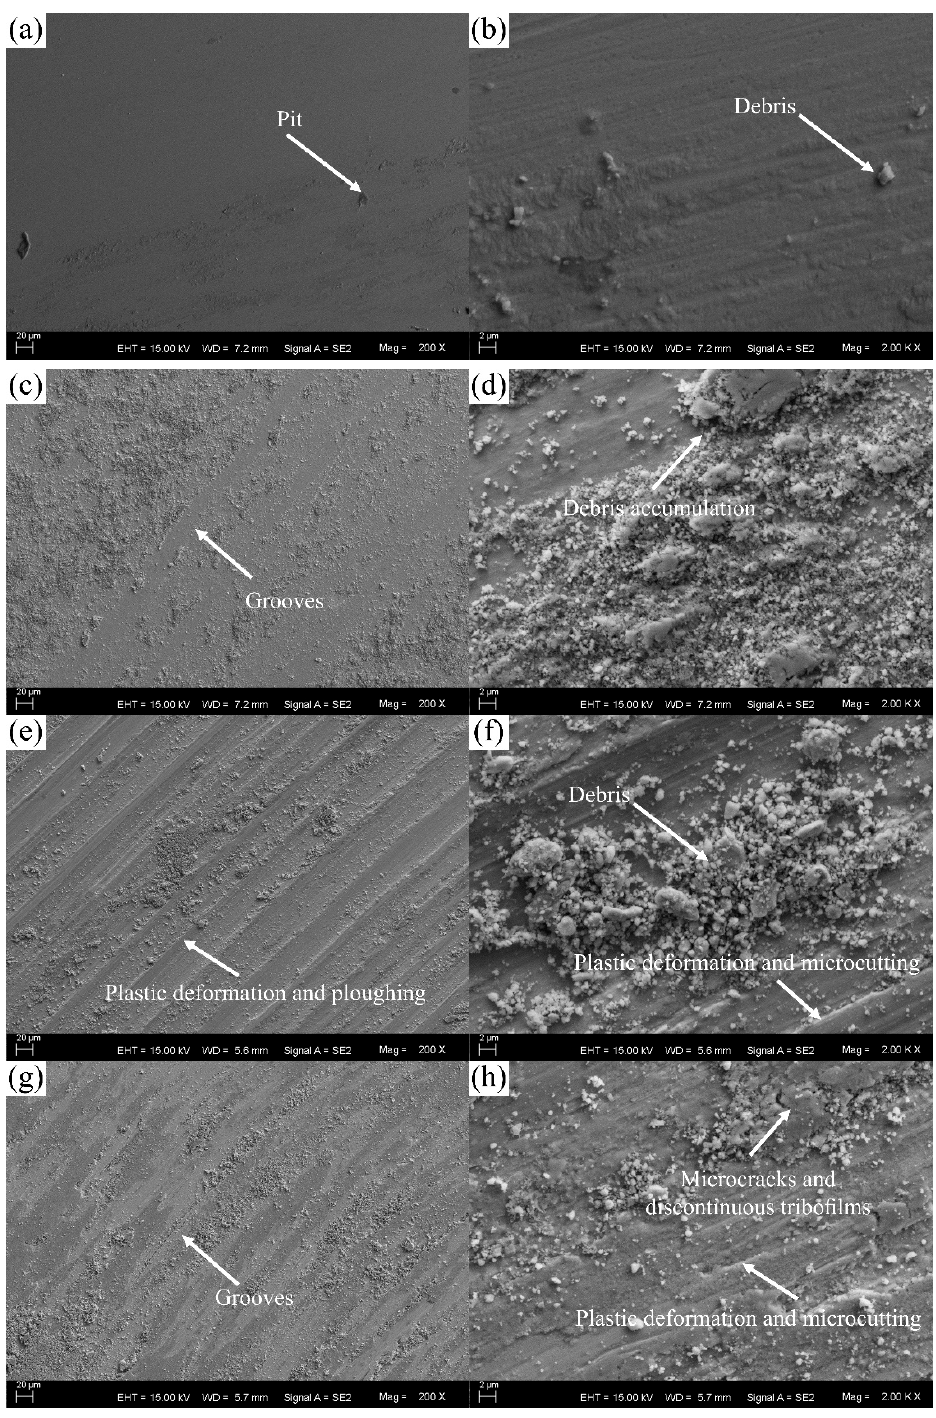
Figure 6. The worn surfaces of H13 steel at different temperatures: ( a , b ) 25 °C; ( c , d ) 200 °C; ( e , f ) 400 °C; and ( g , h ) 600 °C.